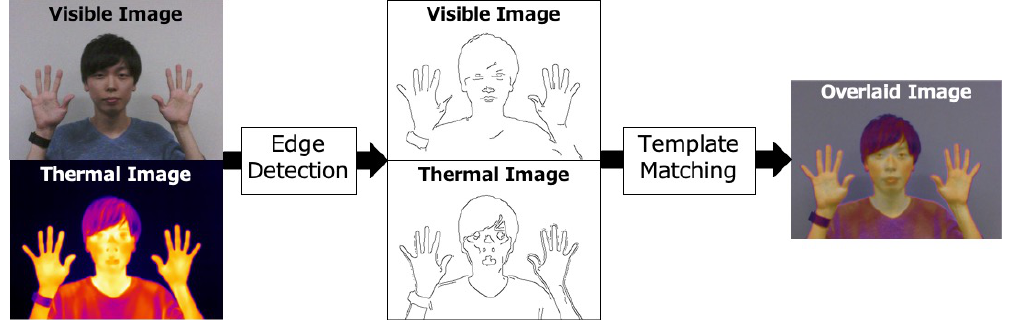
Figure 4. Image pre-processing